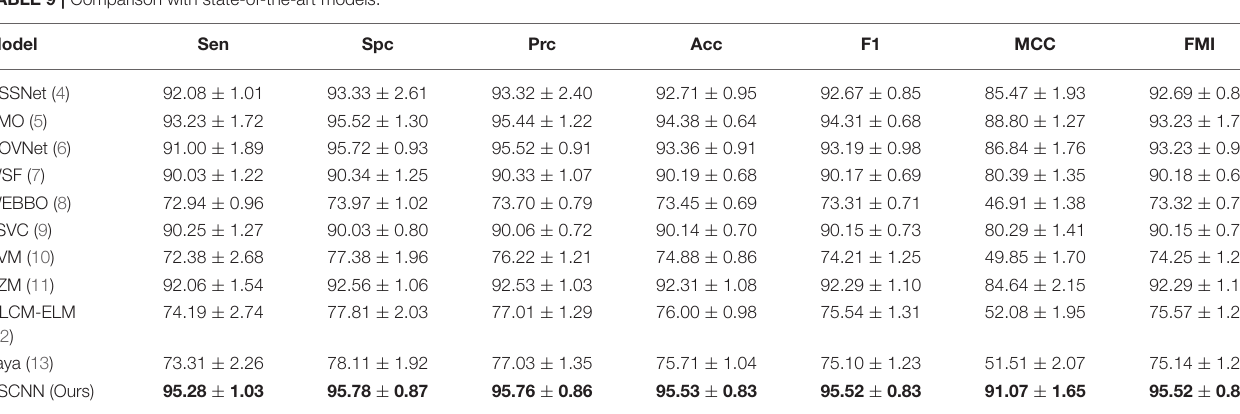
TABLE 9 | Comparison with state-of-the-art models.